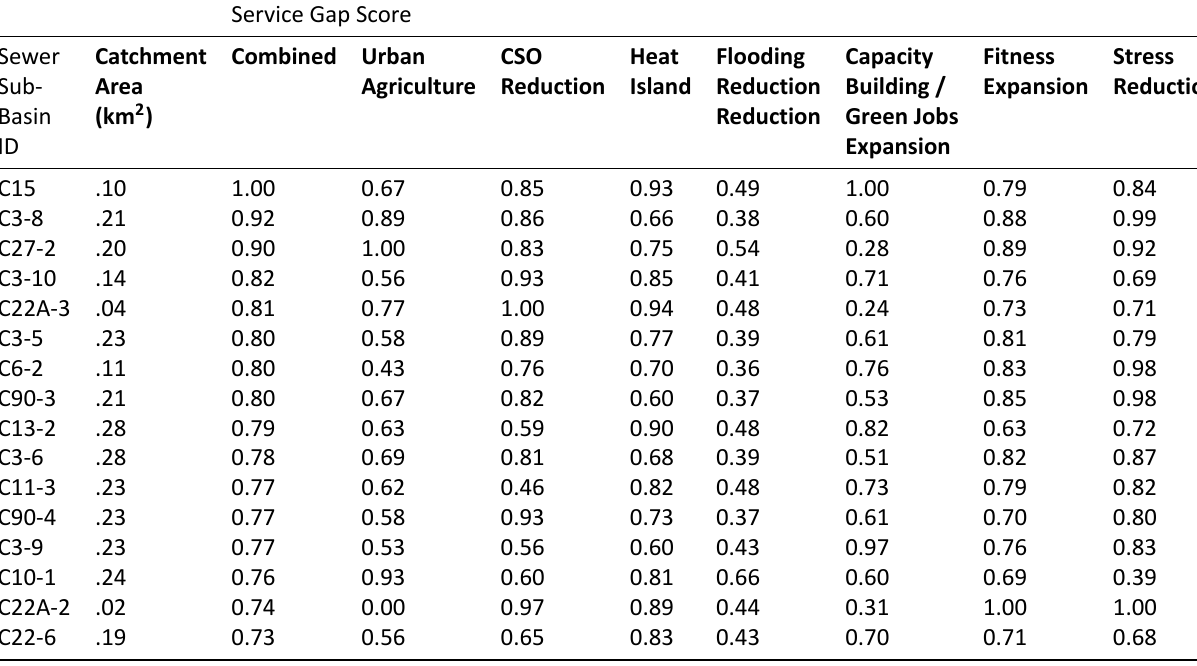
Table 3. Top 20 th percentile sub-basins for combined service gap score. Service Gap